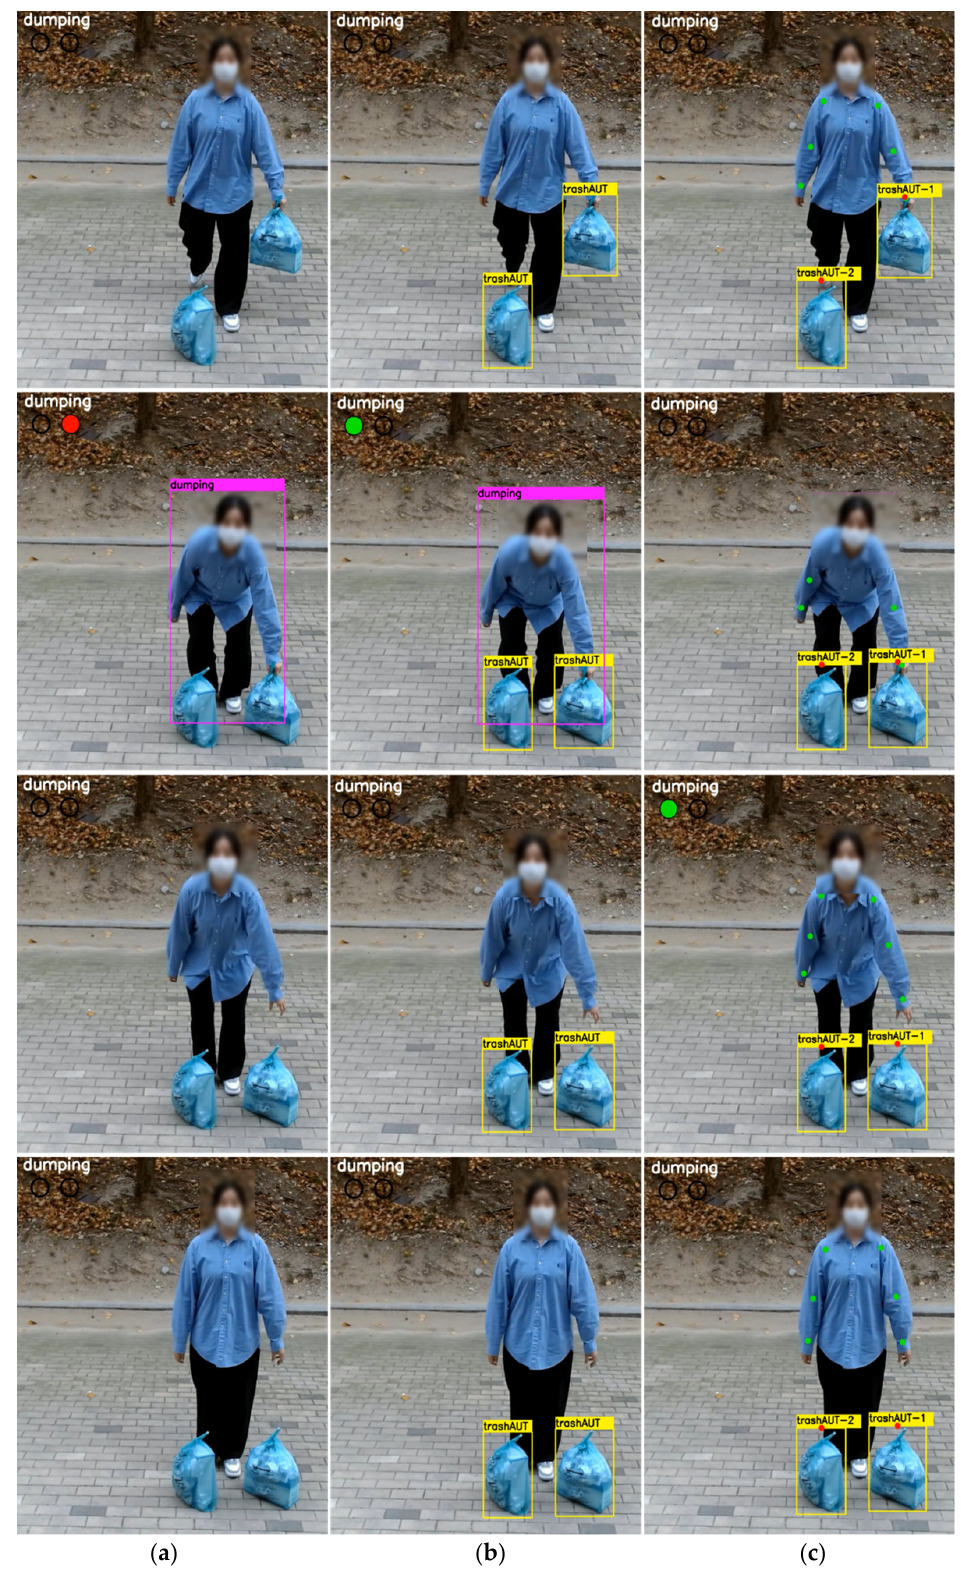
Figure 6. Illustrations of the outcomes from the monitoring models for the disposal of the legal standard garbage bag in one hand; ( a ) [7], ( b ) Post+det, and ( c ) Proposed AIDM.